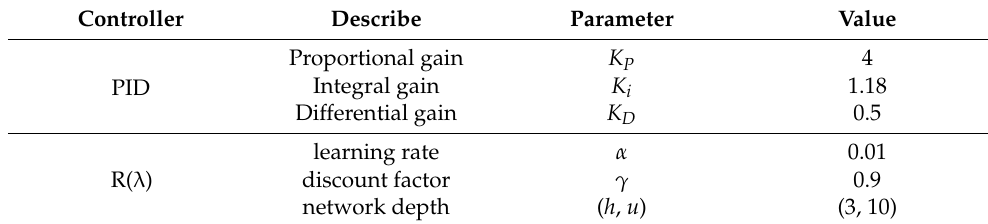
Table 3. PID and R( λ ) controller system parameters.